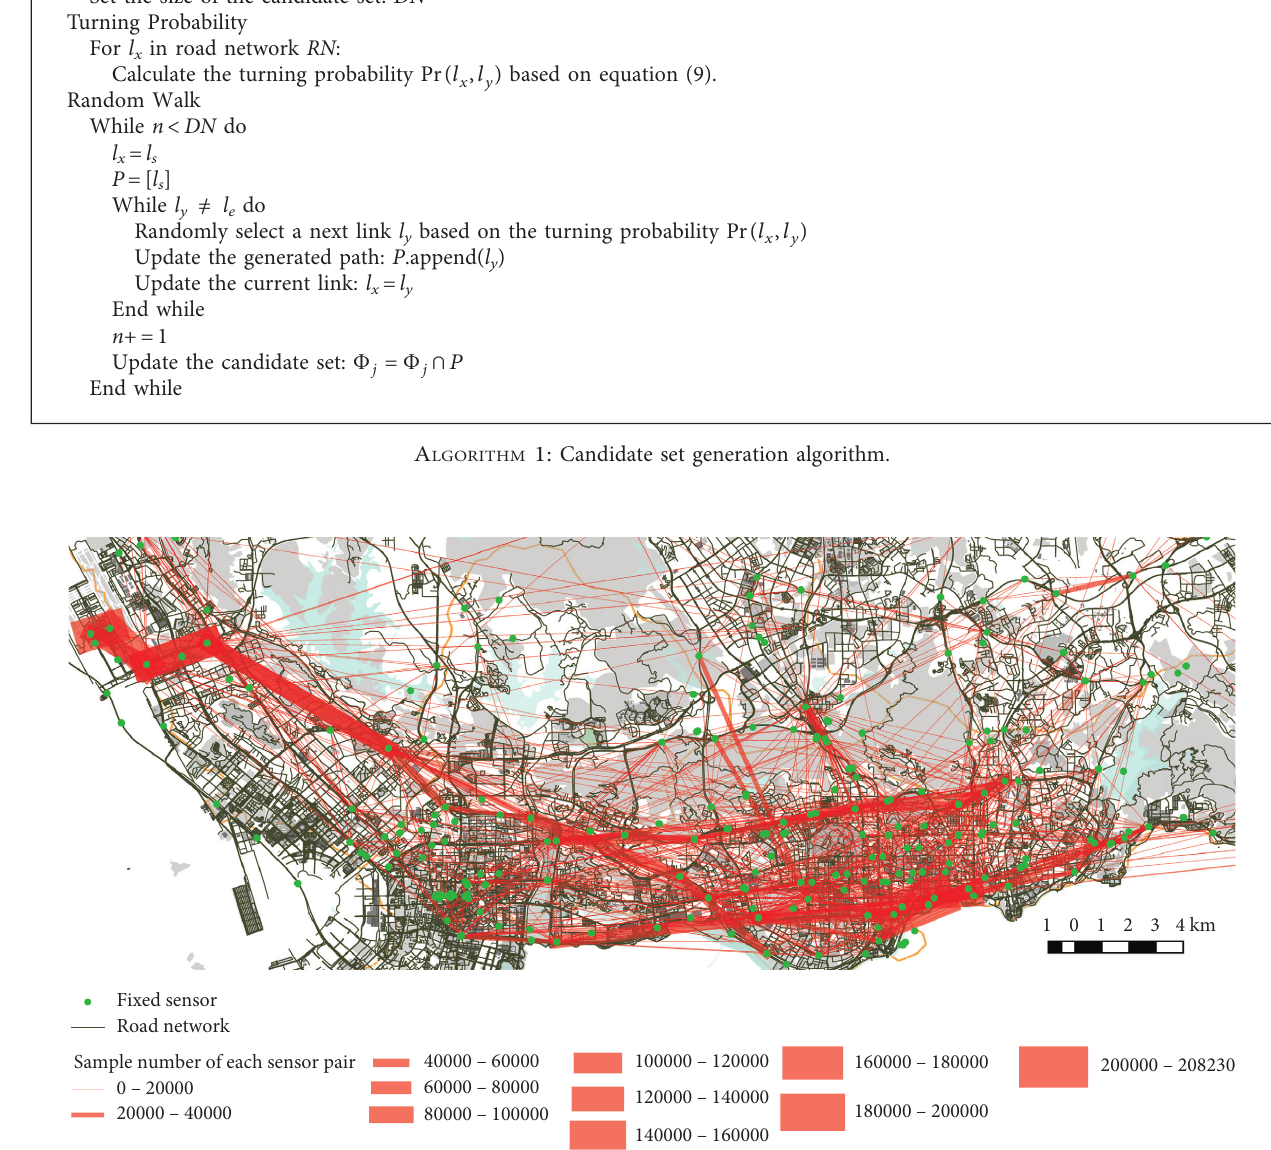
Figure 8: Distribution of observed